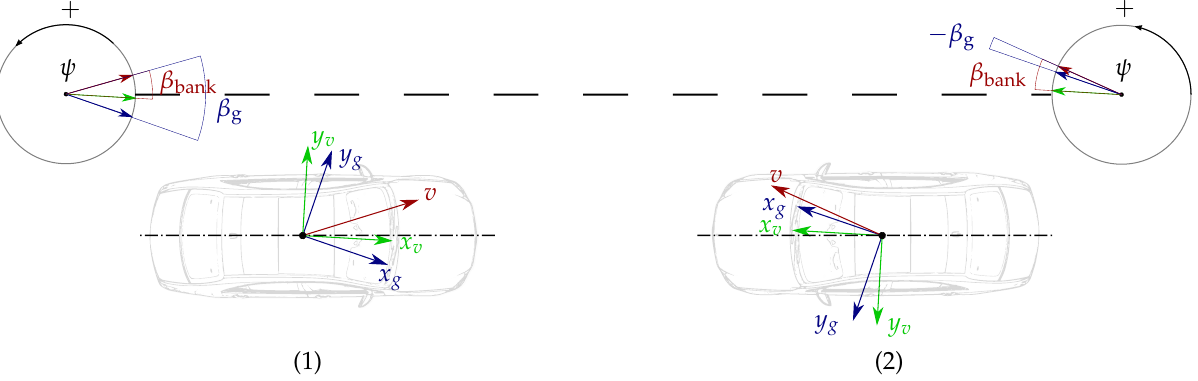
Figure 7. Yaw calibration procedure on a non-horizontal road. The dashed and continuous lines respectively represent the visual division between lanes and the road limit. The vehicle drives on the same lane twice but in opposite directions. The upper left and right circles show the direction of positive yaw angles for the corresponding driving directions. The red, green and blue arrows in the circle depict the directions of the velocity vector, the x -axis of the vehicle CS and the x -axis of the ground-truth CS, respectively. β bank is the side-slip angle stemming from the road bank and β g the direction in which the ground-truth perceives the velocity vector.